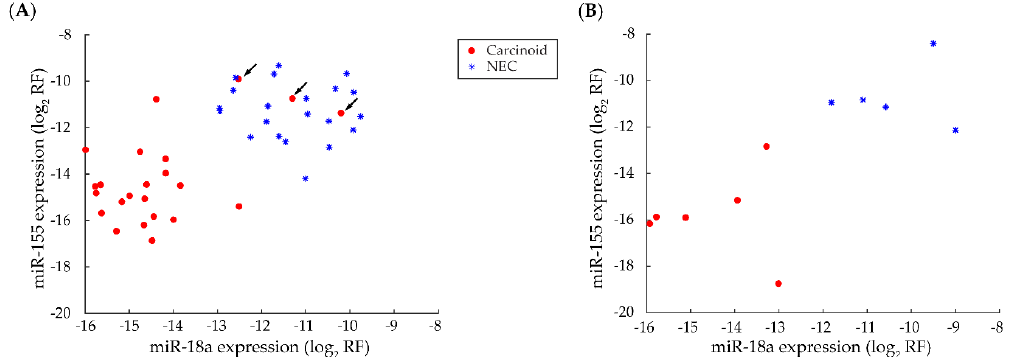
Figure 2. Scatter plot assessment of selected individual miRNAs for discriminating carcinoids from neuroendocrine carcinomas (NECs). Carcinoids and NECs were discriminated using miR-18a and -155, with three misclassifications in the discovery set ( A ) and no misclassification in the validation set ( B ). Abbreviation: log 2 normalized relative frequency (log 2 RF). Table 3. Overall accuracy of the miRNA-based classifier for discriminating lung NENs. Hierarchical Classifier